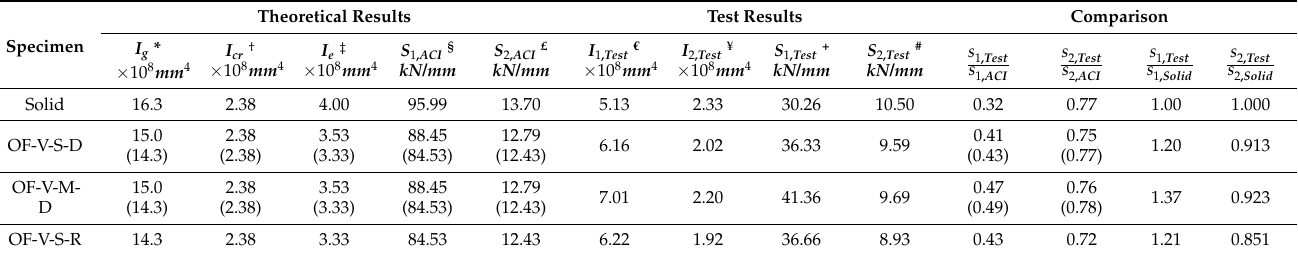
Table 9. Moment of inertia and flexural stiffness of the